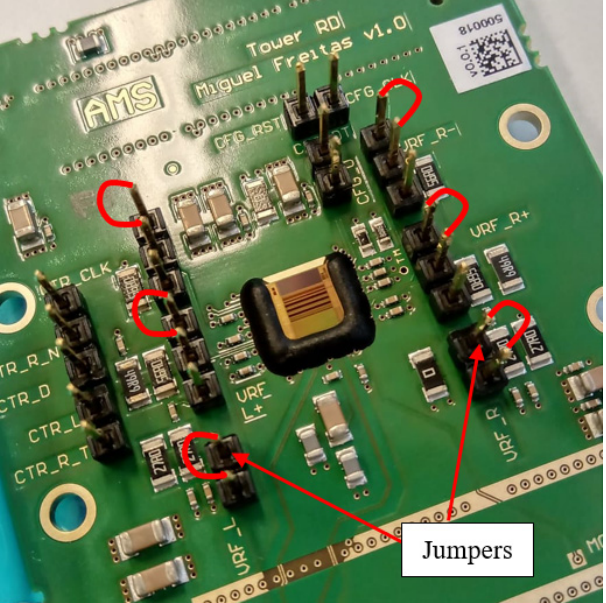
Figure 6. PCB board with pin-headers ready for external references generation and usage through the external connection with jumpers.